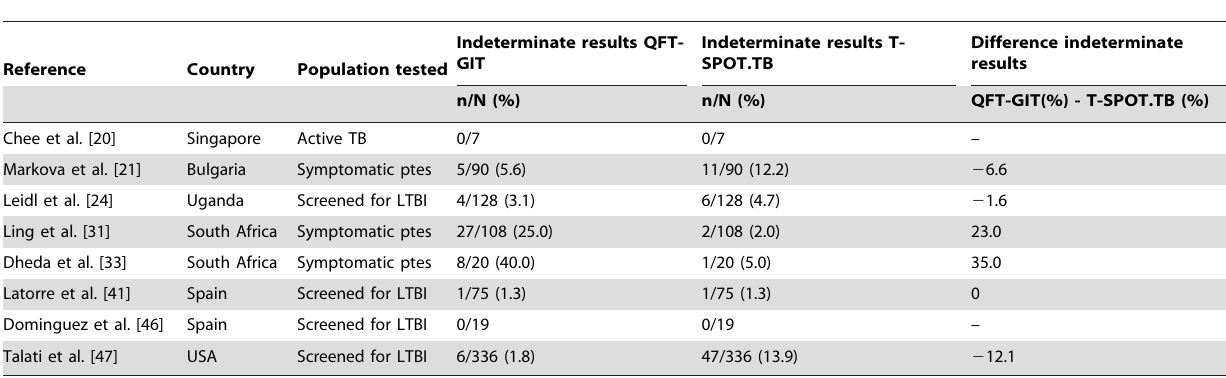
Table 6. Head-to-head comparison of the proportion of indeterminate results between QFT-GIT and T-SPOT.TB in HIV-infected